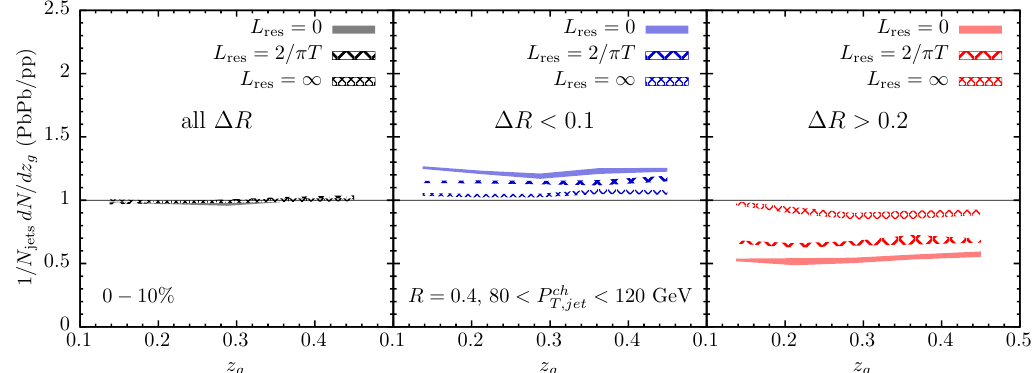
Figure 7 . Results from the hybrid model calculation of the ratio between the z g distribution in PbPb and pp collisions, with di(cid:11)erent choices of L res , depicted via bands with di(cid:11)erent (cid:12)llings. Each panel shows a di(cid:11)erent choice for the cut on the angular separation (cid:1) R between the two groomed subjets. Each curve has been normalized to the total number of jets, N jets .